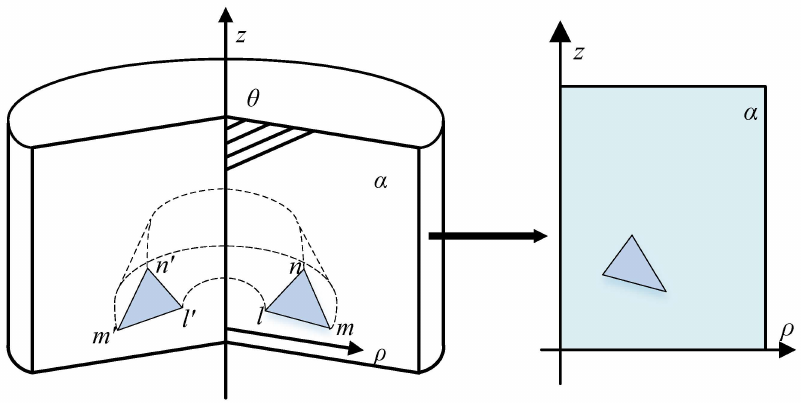
Figure 1. Axisymmetric analysis model from three-dimensional field